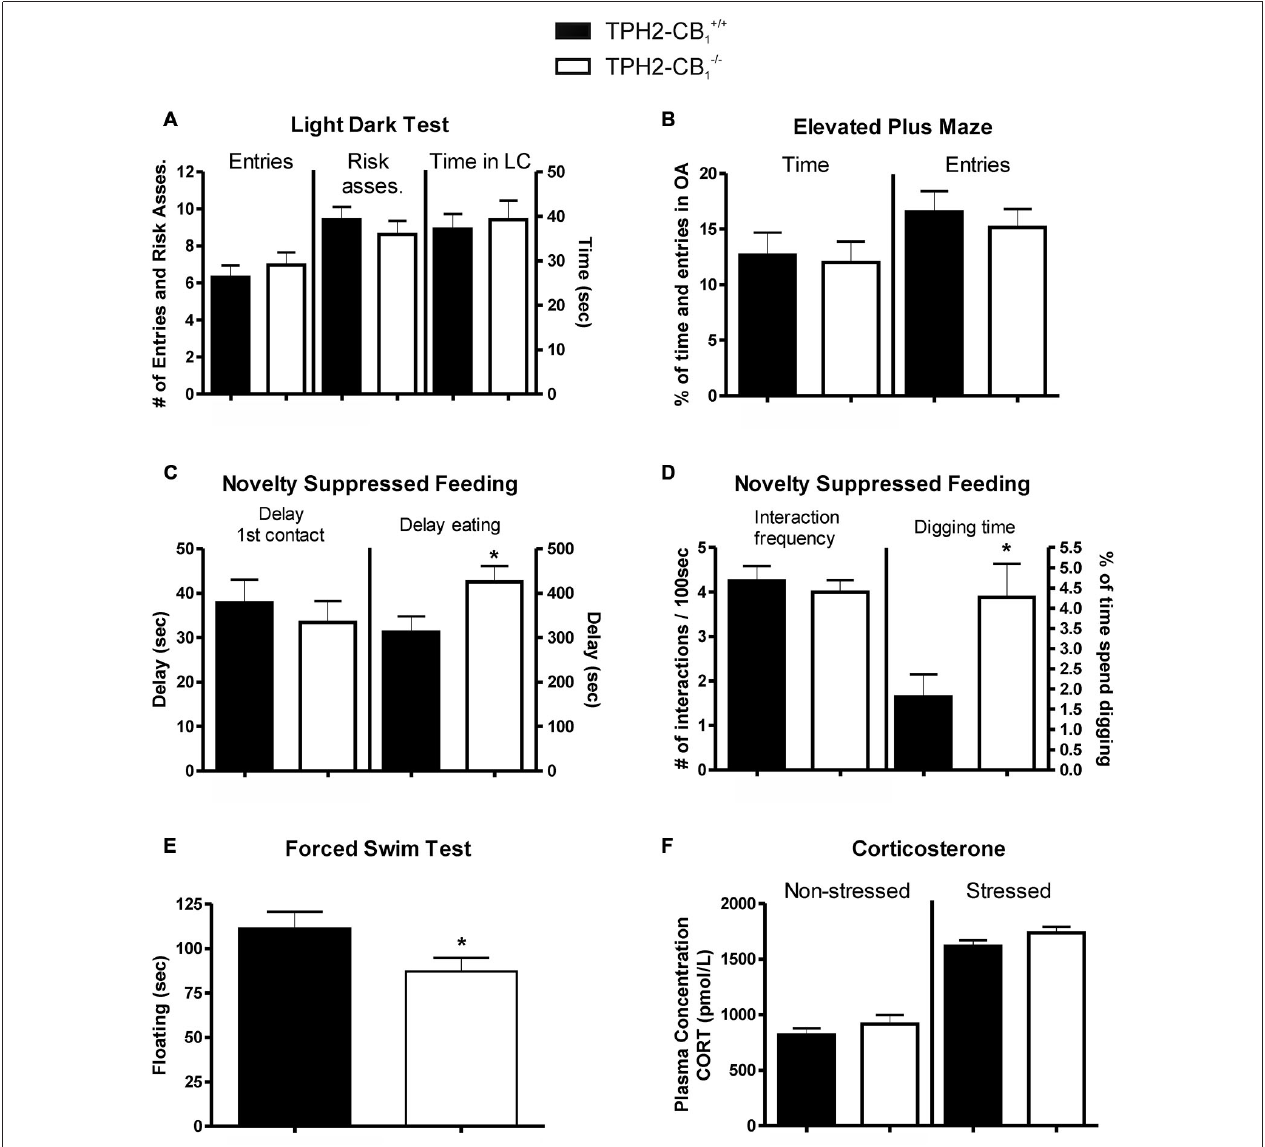
FIGURE 3 | Anxiety and stress response. No genotype differences were observed in basic anxiety tests, such as (A) the light dark test (LDT) and (B) the elevated plus maze (EPM). (C) Increased aversive environment in the novelty suppressed feeding (NSF) test induced anxiety-like behavior in TPH2-CB1 − / − mice. Although no genotype differences were observed in the time required for the first contact, mutants showed a delayed time to start eating. (D) While the frequency of interactions with the food pellet was not altered, a significant increase in the percentage of time spent digging was observed. (E) Mutants displayed a decreased floating behavior in the forced swim test (FST) as compared with control littermates. (F) No genotype differences were observed in plasma corticosterone concentrations, neither in basal conditions (non-stressed) nor 5 min after the FST (stressed). Risk asses = risk assessment; LC = lit compartment; n [ EPM + LD ] = 41 WT + 49 KO; n [ NSF ] = 32 WT + 33 KO; n [ FST ] = 20 WT + 22 KO; ∗ p <